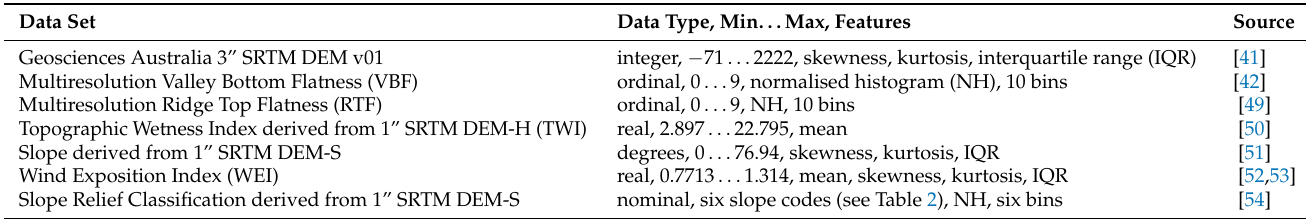
Table 1. Source data set, data type, and range of a total of 37 features. Most features are generated by computing normalised histograms (NH); some are simple statistics such as mean, skewness, and kurtosis.